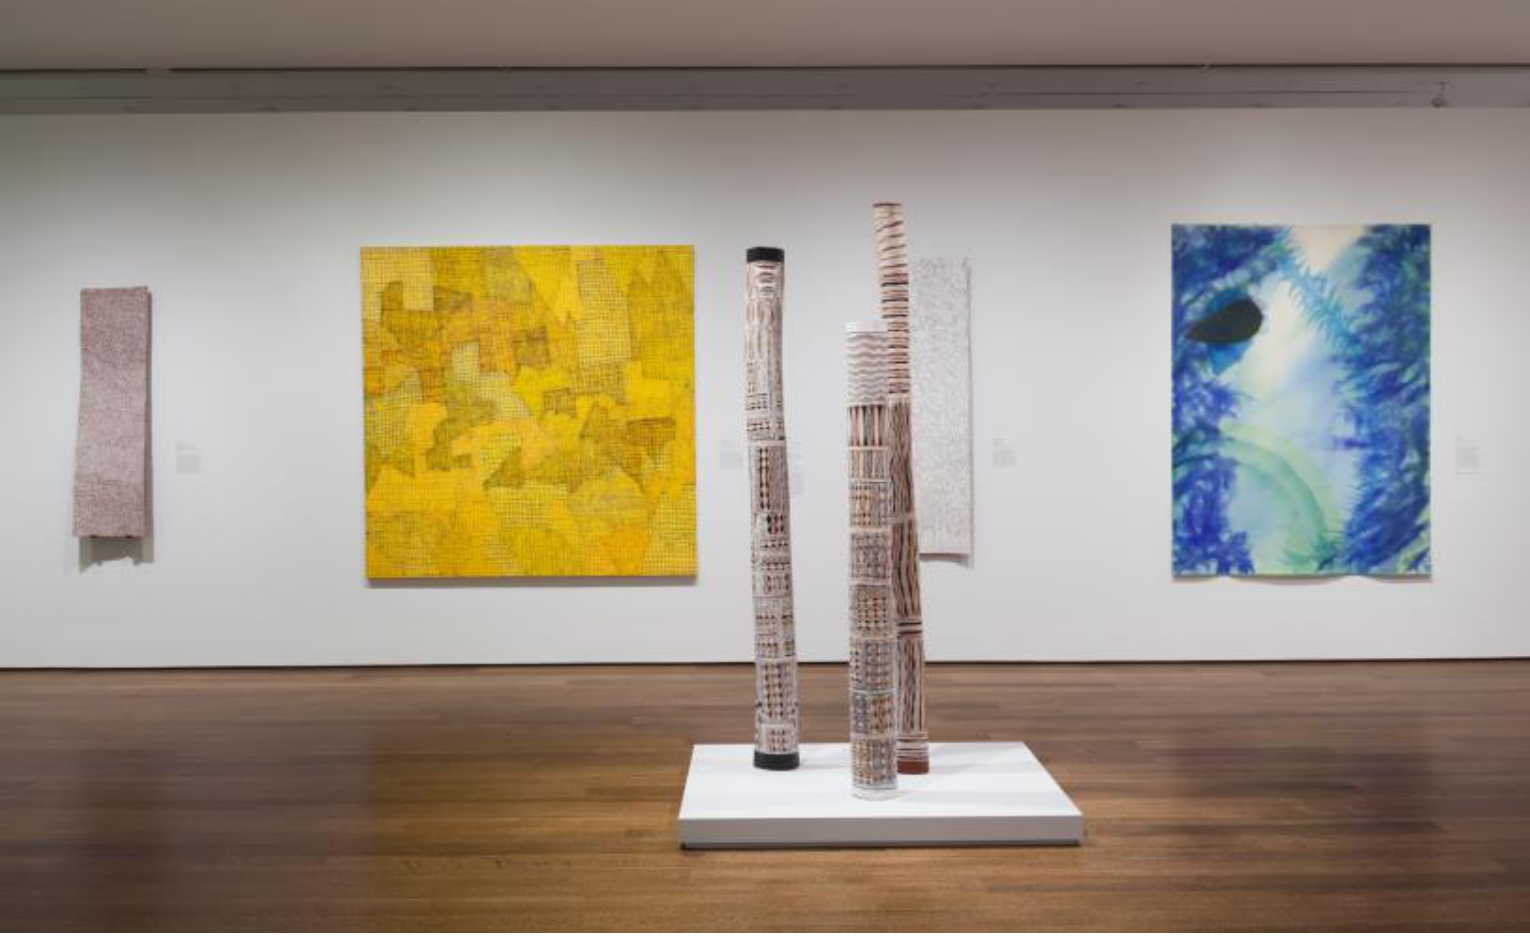
Contemporaneity: Historical Presence in Visual Culture http://contemporaneity.pitt.edu Vol 5, No 1 “Agency in Motion” (2016 ) | ISSN 2155-1162 (online) | DOI 10.5195/cont.2016.183